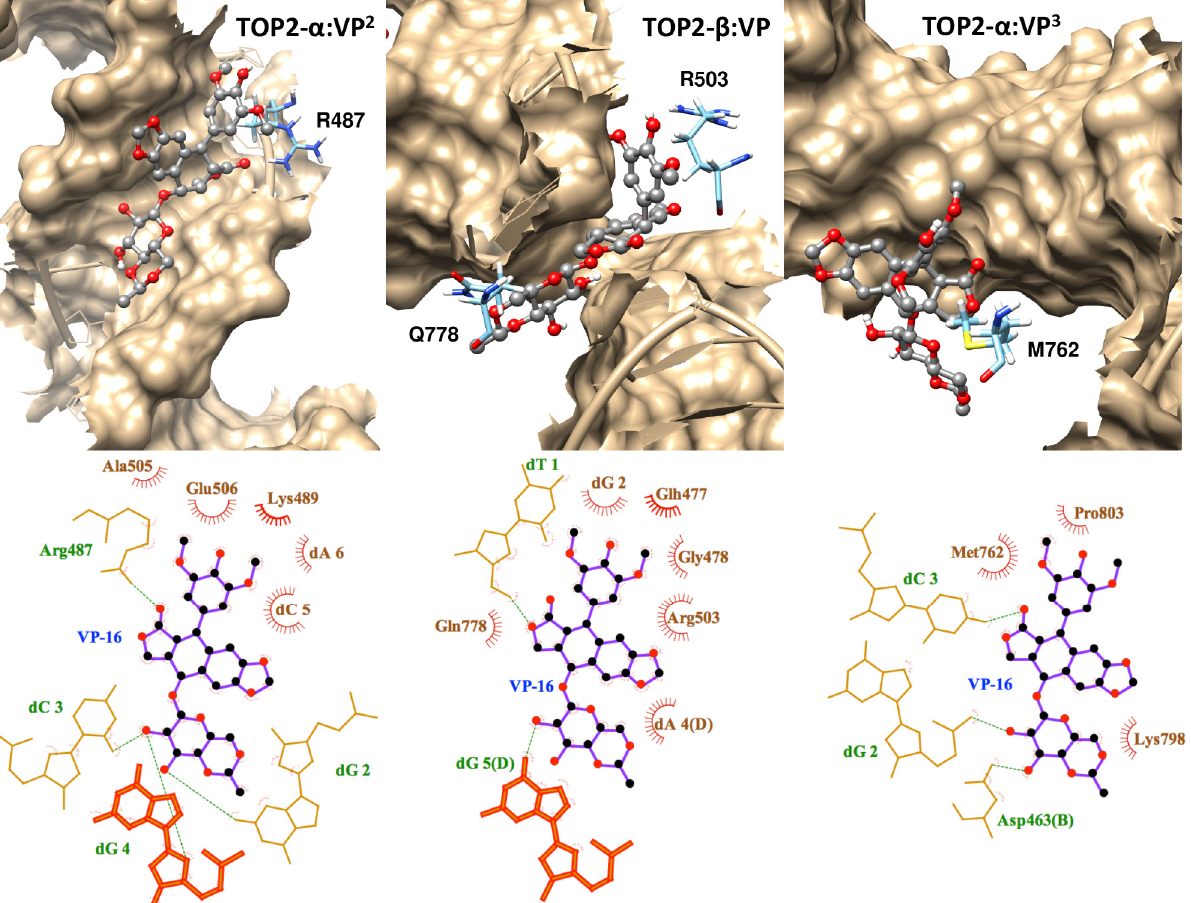
Figure 5. Interaction diagrams of VP-16 with the cleavage complexes of TOP2- α and TOP2- β ( middle ). Both the high-affinity ( left ; VP 2 ) and the low-affinity ( right ; VP 3 ) binding modes of VP-16 in the ternary complex of TOP2- α are shown. Upper panel, molecular graphics with labels on the R487/R503 and M672/Q778 of the enzymes and molecular surface of the cleaved DNA. Lower panel, the 2-dimensional maps are plotted by fitting the orientation of the